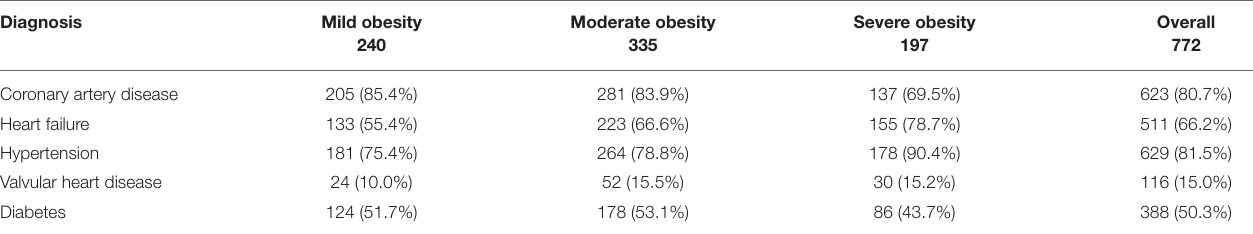
TABLE 1 | General characteristics of patients.